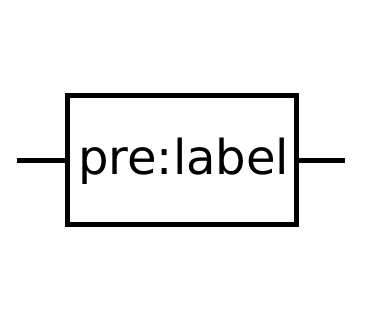
Figure 2.7: The Activity Flow glyph for unit of information